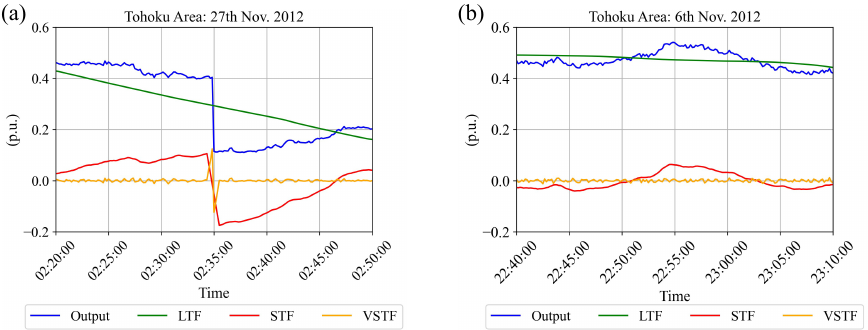
Figure 9. The largest and smallest short-term fluctuations (STFs) in the Tohoku area in the 2012 fiscal year. ( a ) An event on 27 November induced these fluctuations. ( b ) An event on 6 November induced one of the largest STFs. LTF: long-term fluctuation, VSTF: very short-term fluctuation.